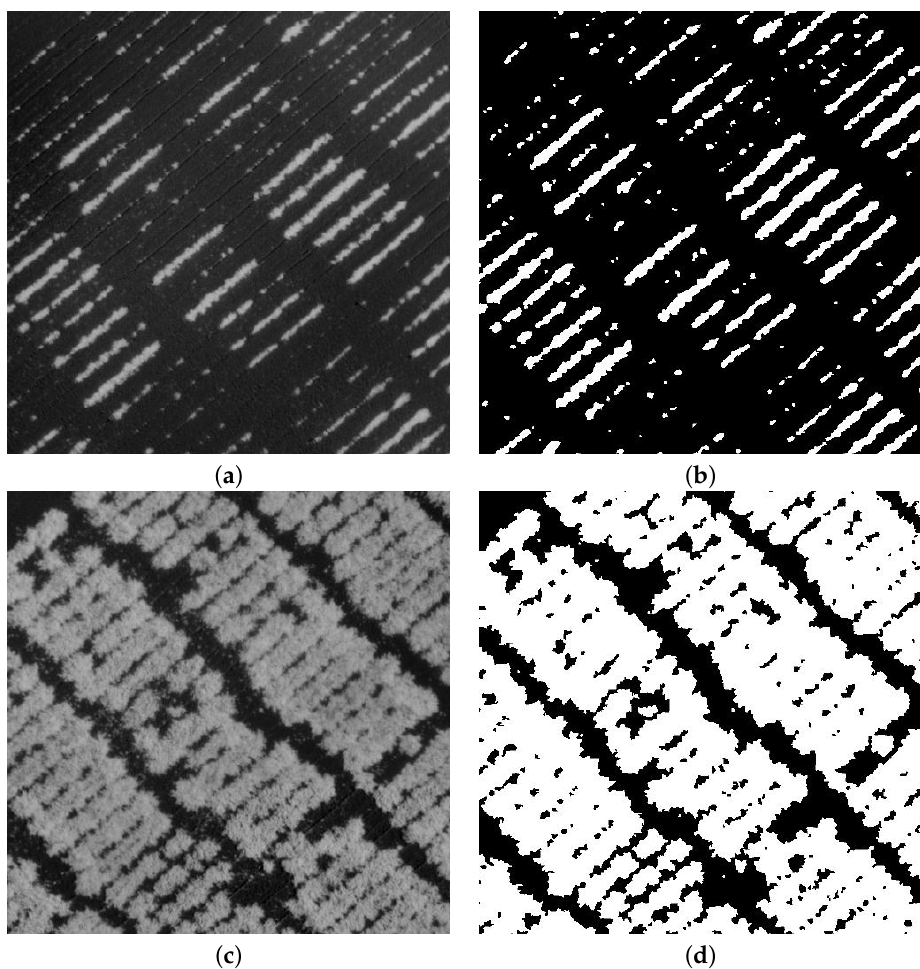
Figure 7. NDVI maps and their segmented image ( TP and NTP ) for date: 21 November 2019 ( a , b ), 44 days after transplant, and 29 January 2020 ( c , d ), 113 days after transplant.